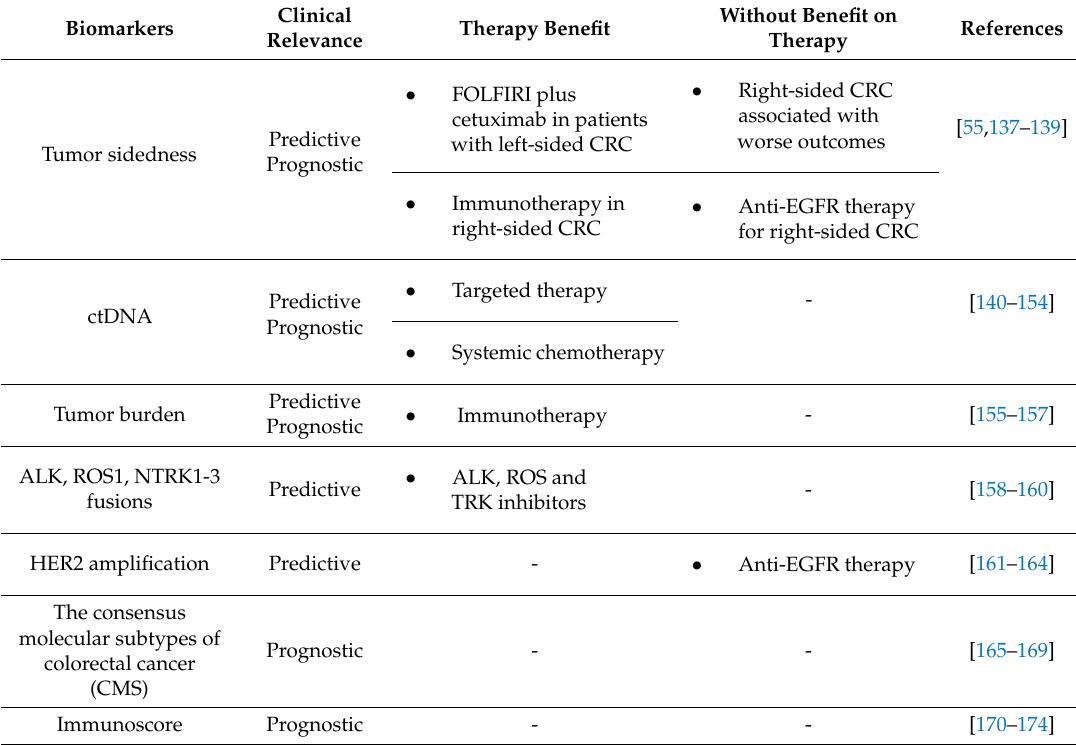
Table 1. The list of biomarkers used in clinical practice of metastatic colorectal cancer (mCRC).